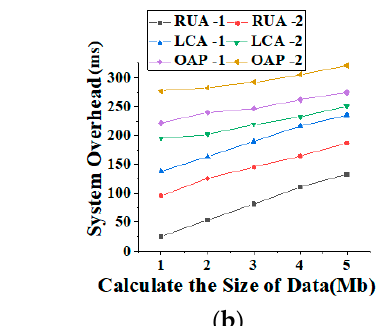
( b ) Figure 8. Influence of the mobile device number on the system delay and system overhead: ( a ) the changing trend of the system delay with the increase in mobile devices; ( b ) the changing trend of the system overhead with the increase in mobile devices.